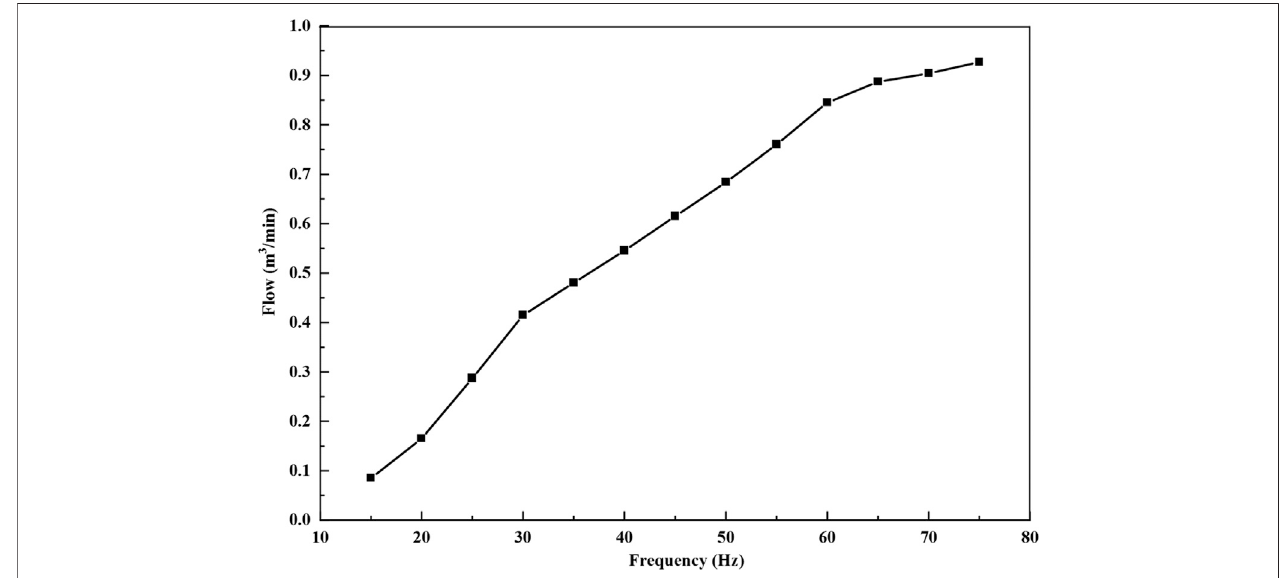
FIGURE 4 | Air fl ow curve with frequency.